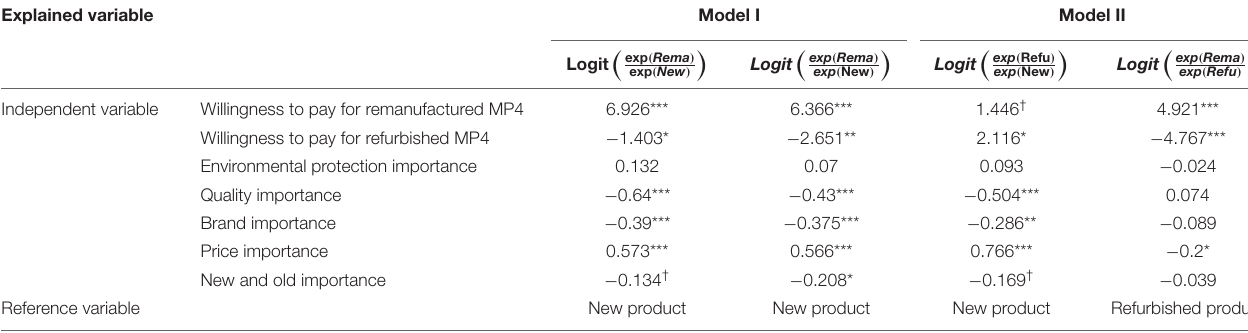
TABLE 7b | Logit regression result of Model I, II (Cartridge, functional